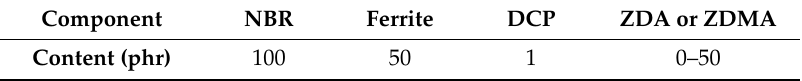
Table 2. Composition of rubber compounds with different amount of